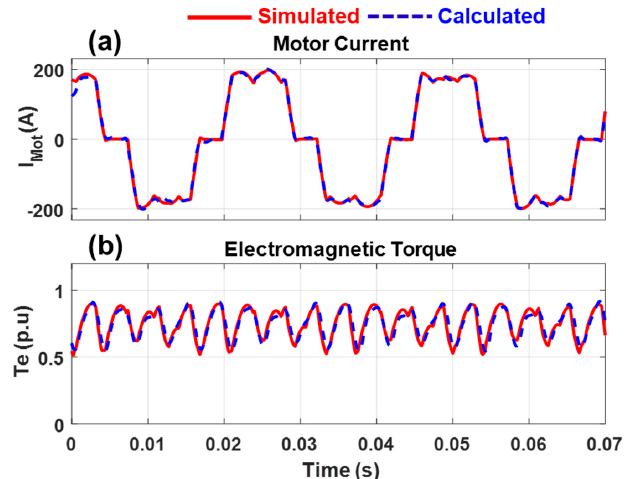
Figure 18. Reconstructed instantaneous electromagnetic torque waveform: ( a ) reconstructed motor current waveform and ( b ) reconstructed torque waveform.